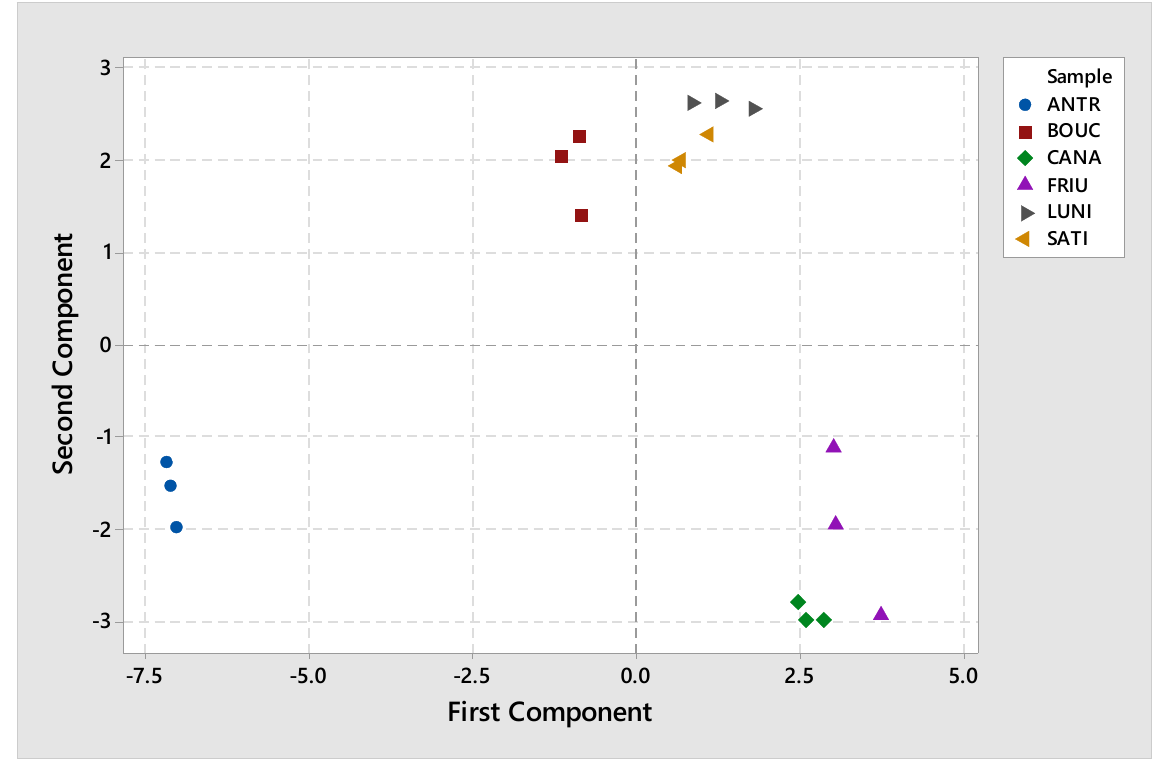
5.02.50.0-2.5-5.0-7.5